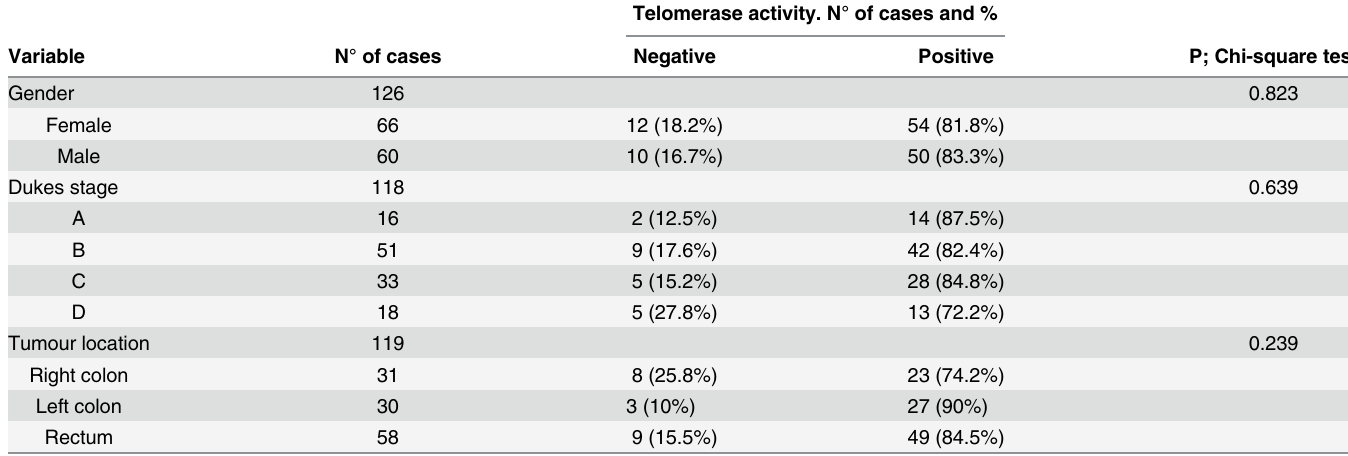
Table 2. Telomerase activity and clinical variables in colorectal